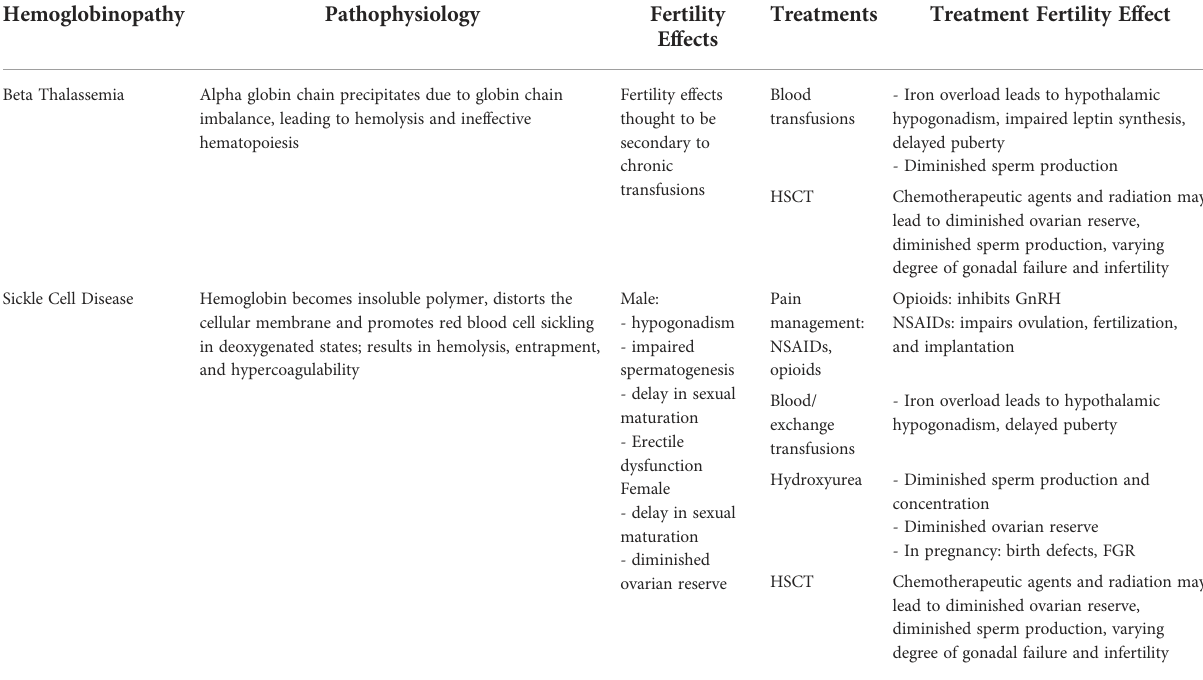
TABLE 1 Hemoglobinopathy pathophysiology, major treatment modalities, and impact on fertility.